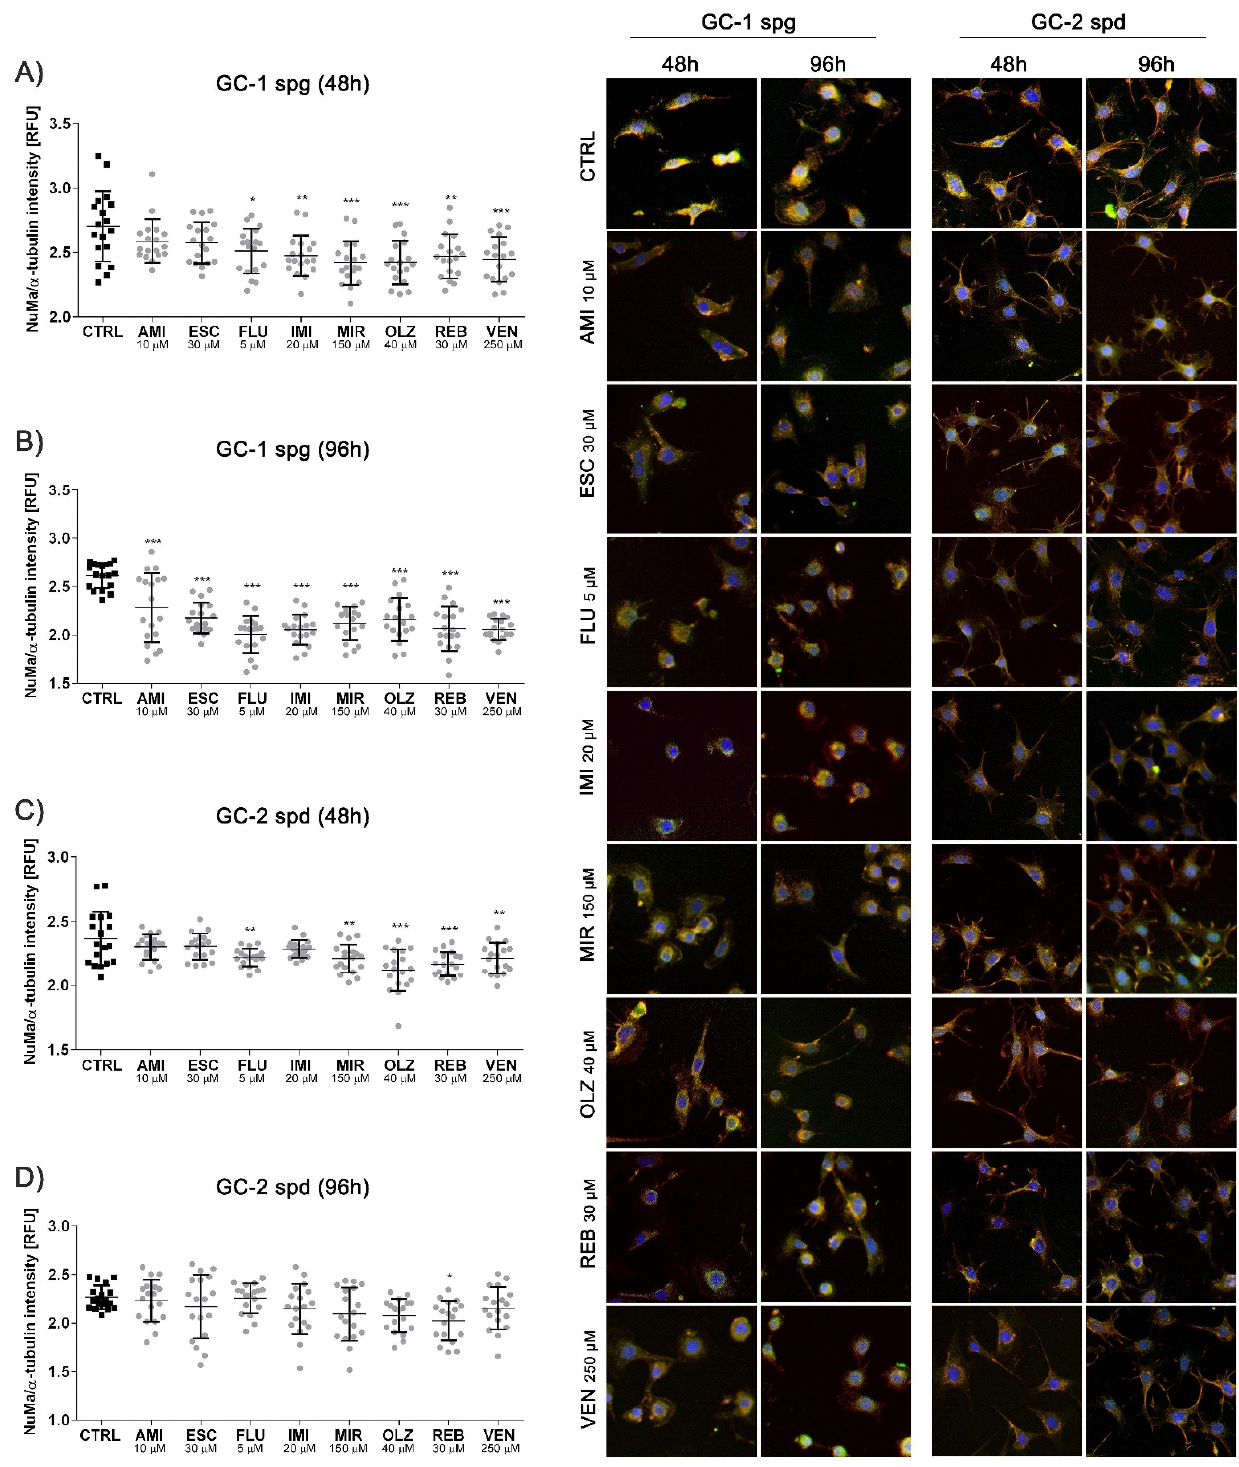
Figure 6. Antidepressants interact between the nuclear mitotic apparatus protein and α-tubulin. Mouse spermatogenic cells were treated for 48 and 96 h and then the immunofluorescence analysis of the interaction between protein stabilizing structures of microtubule-centromeres (NuMa, α-tubulin) at the spindle abnormal formation process were evaluated ( A – D ). Representative photos are shown (magnification 10×). Green fluorescence (FITC) NuMa, red fluorescence (Texas Red) α-tubulin, blue fluorescence (DAPI) nucleus. Statistical differences were determined using one-way analysis of variance (ANOVA) with Dunnett’s post-hoc test; p values < 0.05 were considered statistically significant. Asterisks (*) indicate the comparison between control and antidepressants-treated cells. Bars indicate mean ± SD, n = 18, *** p < 0.001, ** p < 0.01, * p < 0.05, no indication–no statistical significance.